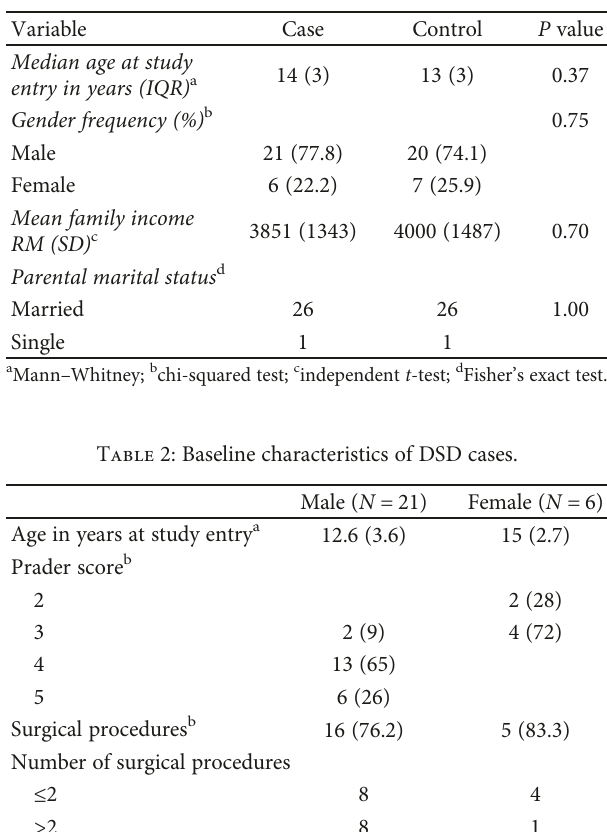
Table 1: Sociodemographic characteristics of cases and control.